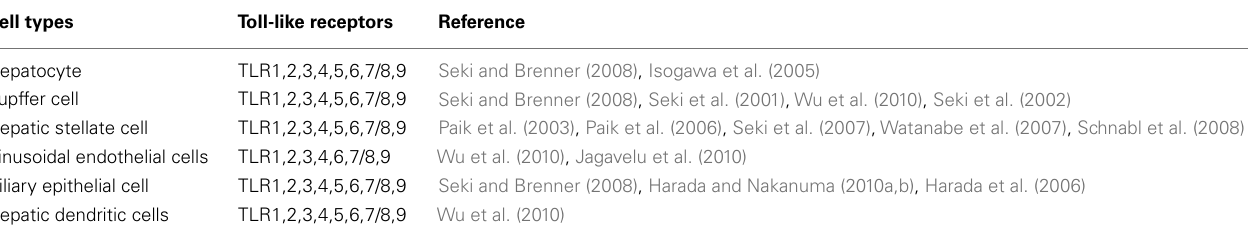
Table 1 |Toll-like receptors expression in the liver cell